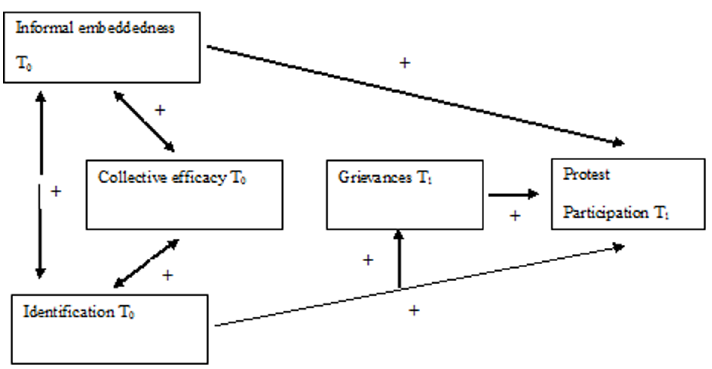
Figure 2. Explanatory model of the three variables at Time 0 and their effect on suddenly imposed grievances and protest participation at Time